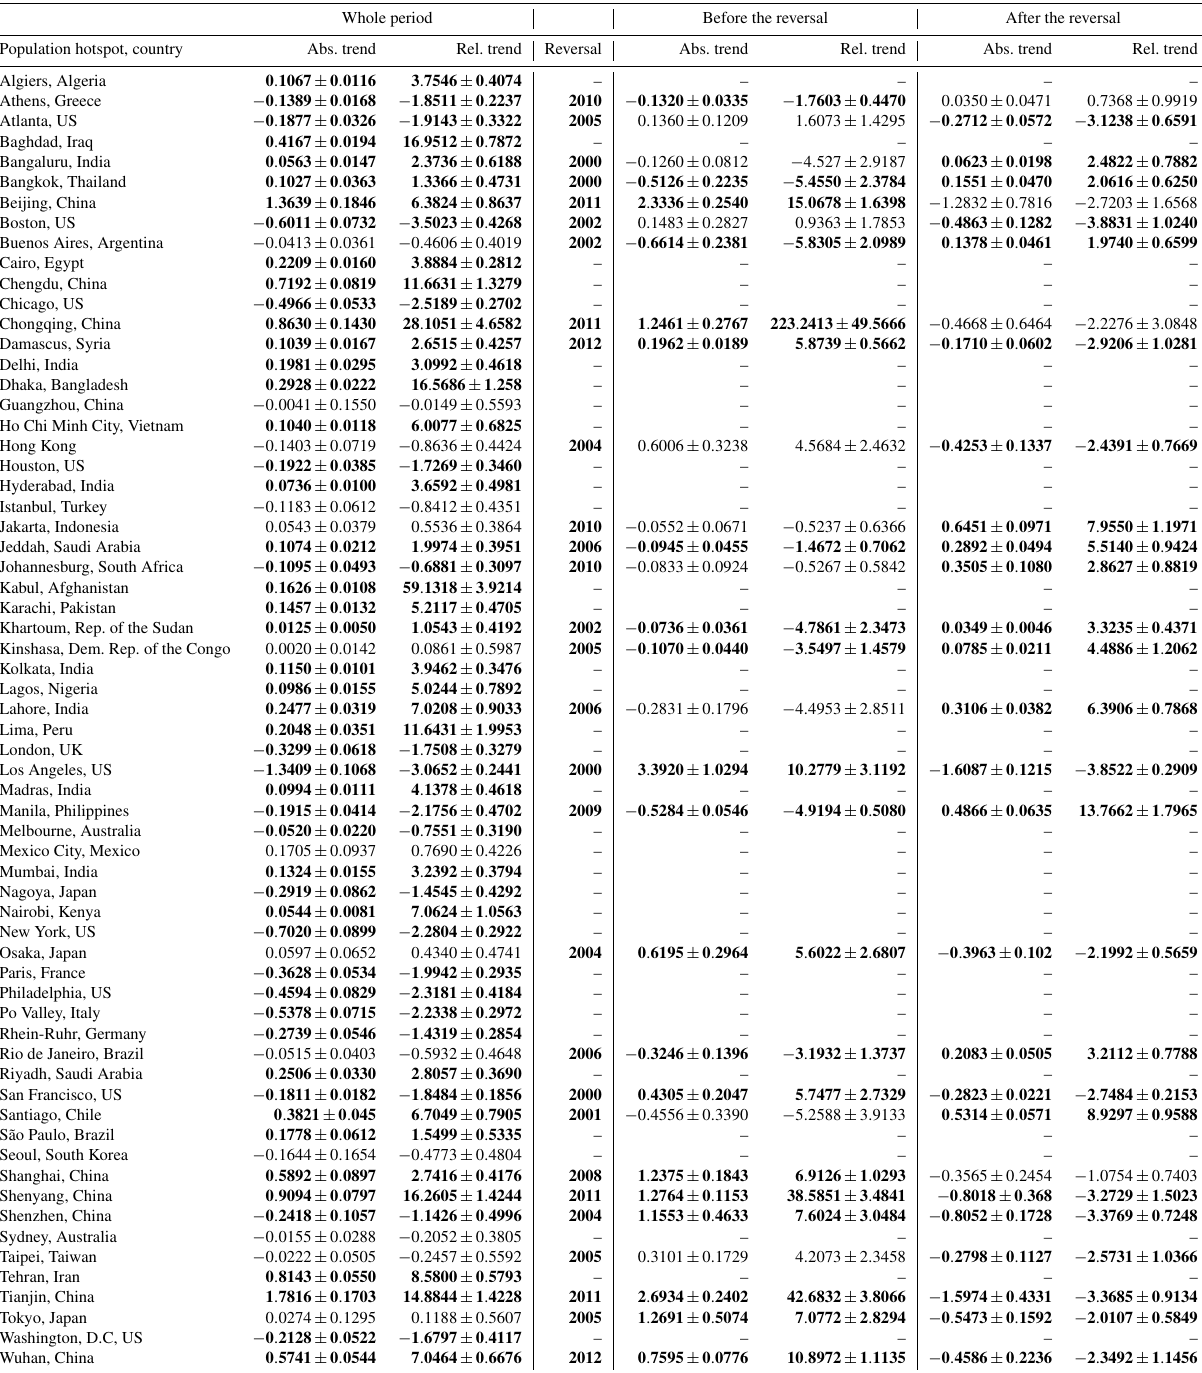
Table 3. The same as Table 1 but for megacities and large urban agglomerations. Bold characters are used to indicate the year of reversal and the statistically significant trends at the 95% confidence